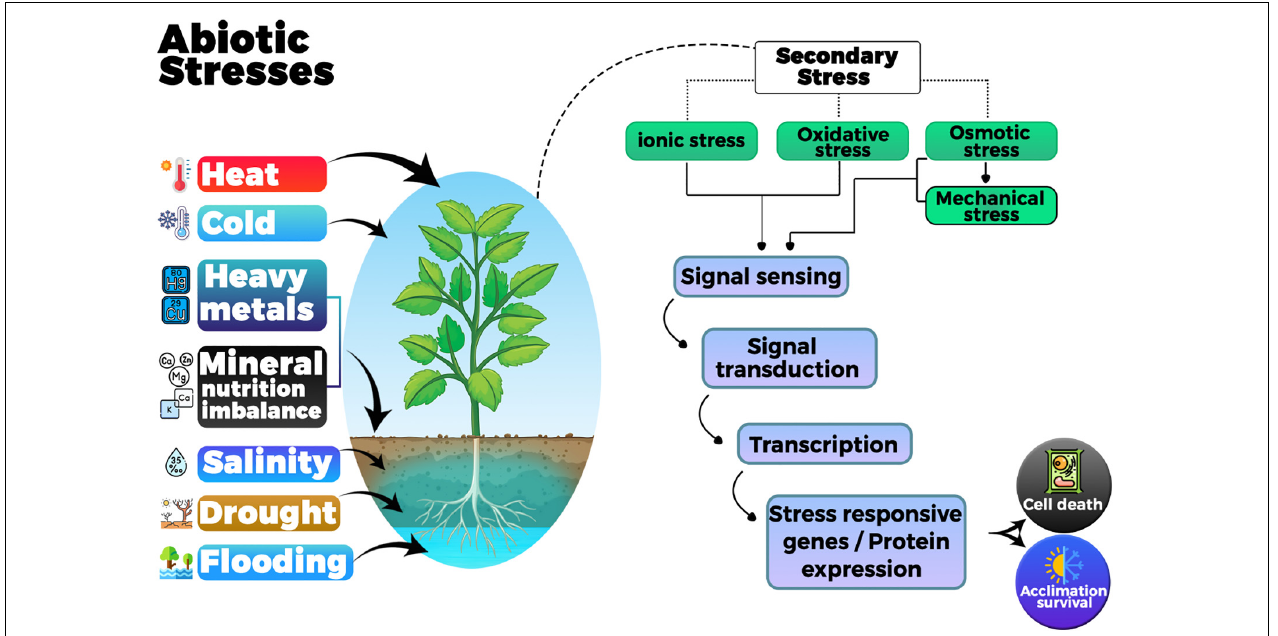
FIGURE 7 | How defense mechanism activates in plants in response to abiotic and biotic